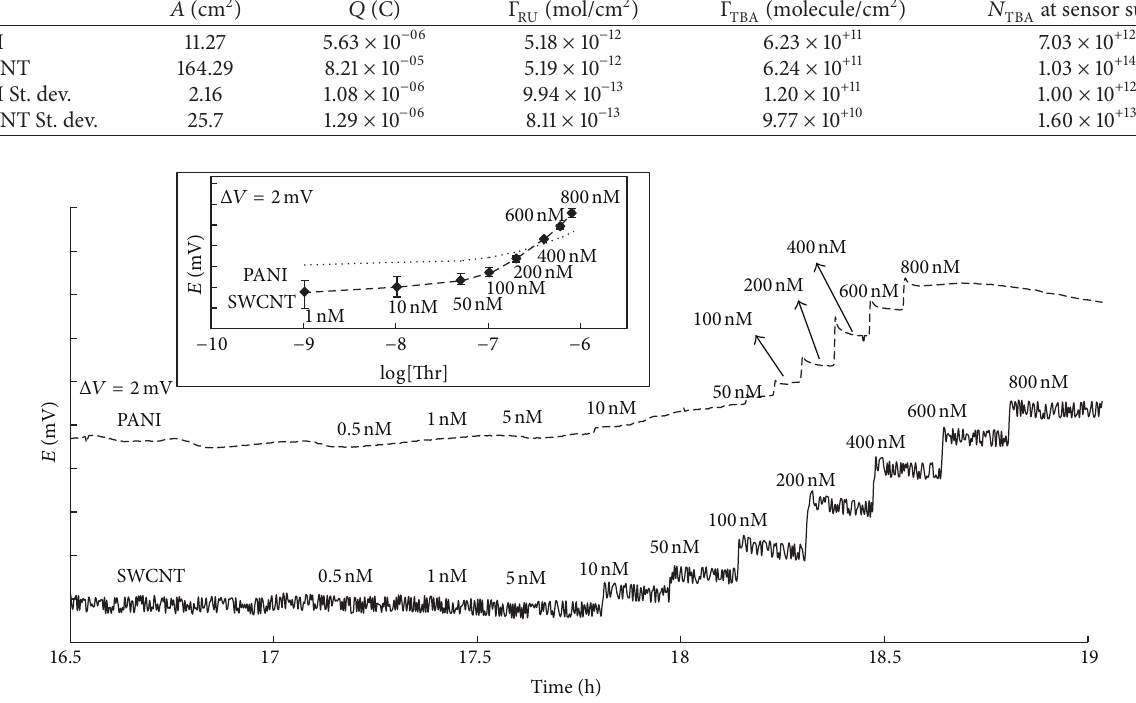
Figure 2: Potentiometric response of the TBA-modified PANI- and SWCNT-based sensors to thrombin. Concentration range is 0,5nM– 800 nM in both cases. The inset shows average calibration curves for the PANI and the SWCNTs potentiometric sensors against thrombin with the corresponding error